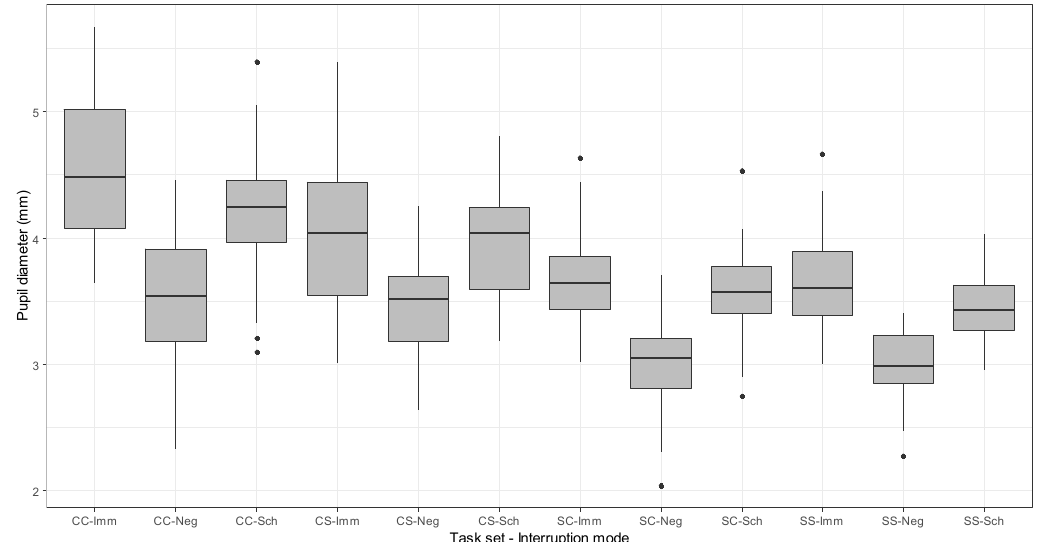
Figure 4. Pupil diameter variation by task set and interruption coordination mode.